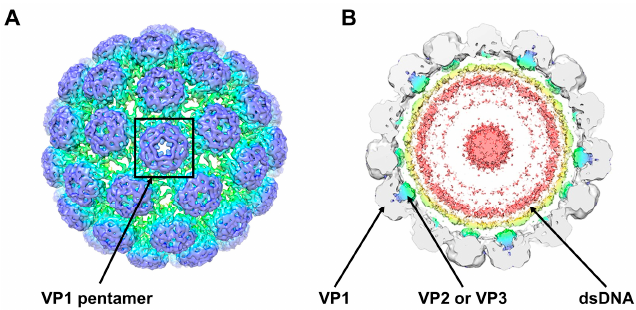
Figure 1. Cryo-electron microscopy structure of BK virus (BKPyV) viral particles (Adapted from [11]). ( A ) External view of the BKPyV virion shown at a contour level of 0.022. A viral protein VP1 pentamer is highlighted; ( B ) View of a 40-Å-thick slab through the unsharpened/unmasked virion map shown at a contour level of 0.0034. Pyramidal density below each VP1 penton and two shells of electron density adjacent to the inner capsid layer can be seen. The density within 6 Å of the fitted coordinates for SV40 VP1 is coloured grey. Density for VP2 and VP3 is coloured blue/green and for packaged double stranded DNA (dsDNA) yellow/pink.